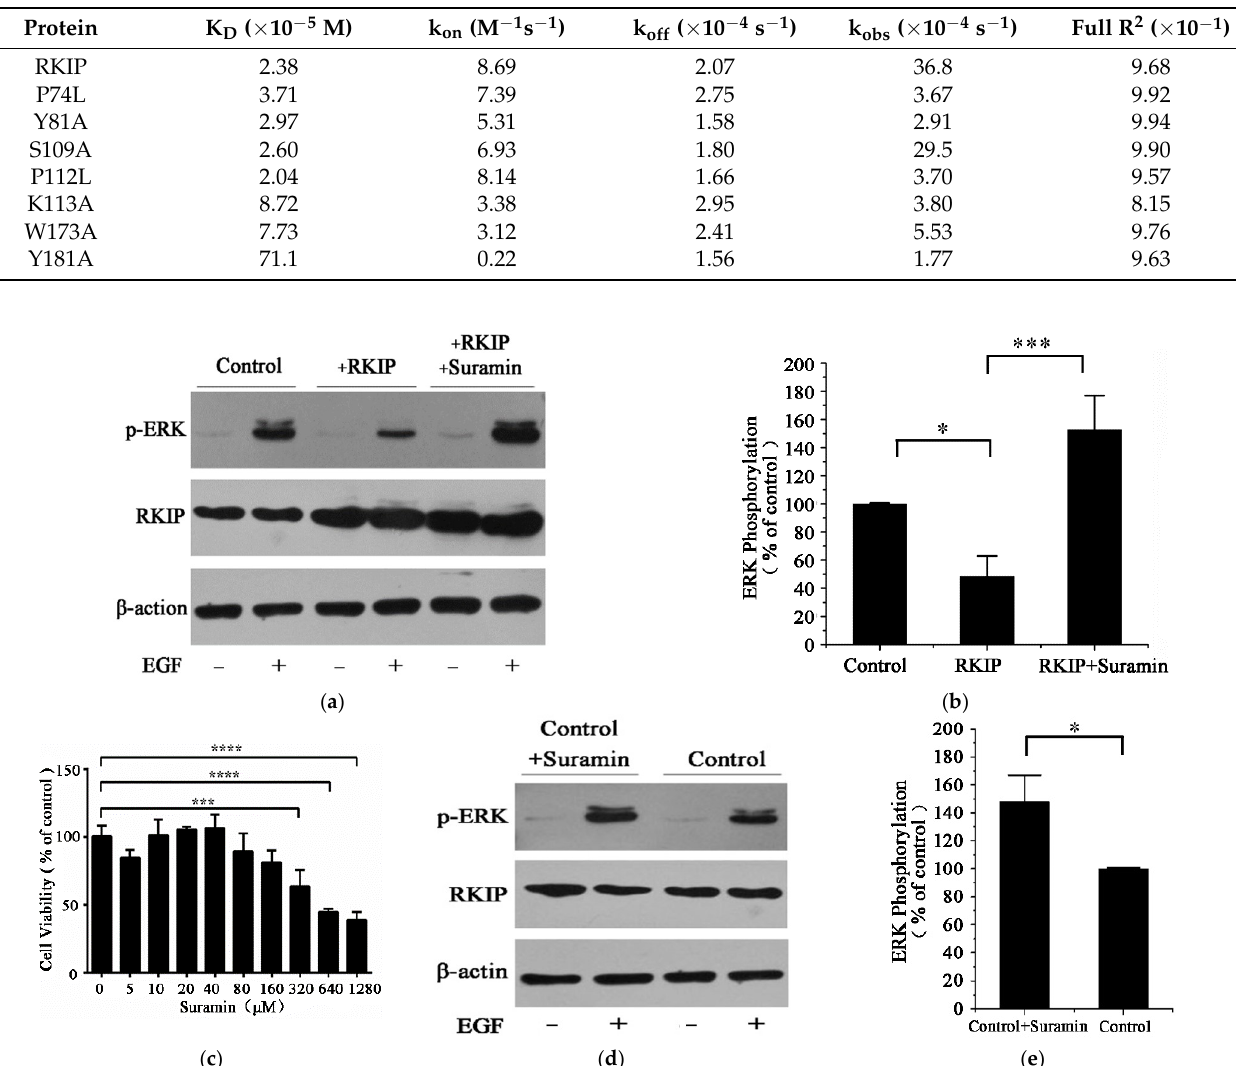
Figure 4. Effects of suramin treatment on hRKIP-mediated Ras/Raf1/MEK/ERK pathway in HEK293 cells ( a , b ) Western blot analysis for the effect of suramin treatment on hRKIP-mediated ERK phosphorylation;( c ) Effect of suramin treatment on viabilities of HEK293T cells transfected with hRKIP. ( d , e ) Western blot analysis for the effect of suramin on the ERK phosphorylation of HEK293T cell. * p <0.1; *** p <0.001; **** p <0.0001, n = 3 for each group.